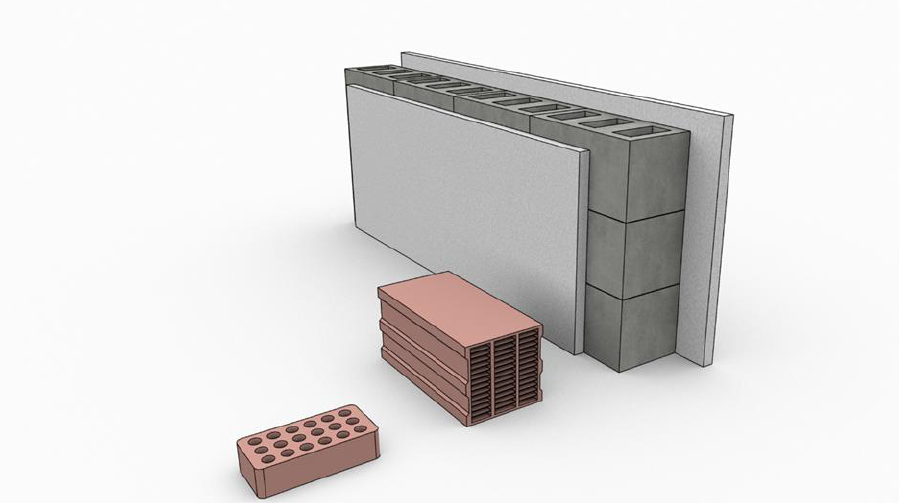
Figure 17. Hollow brick, alveolar brick and wall structure by using PCMs.